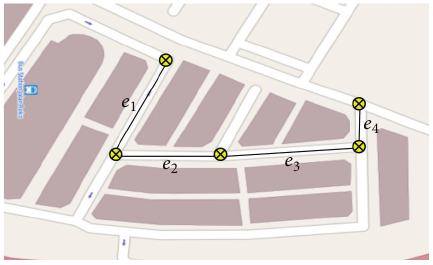
Figure 5: Start and end point of road segments.